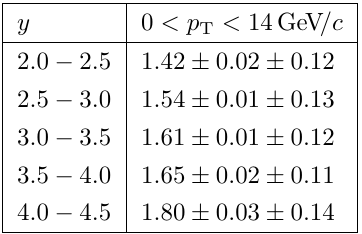
Table 15 . Cross-section ratios between 8 TeV and 5 TeV measurements for nonprompt J/ψ mesons as a function of y with p T < 14 GeV/ c . The first uncertainty is statistical and the second is systematic.